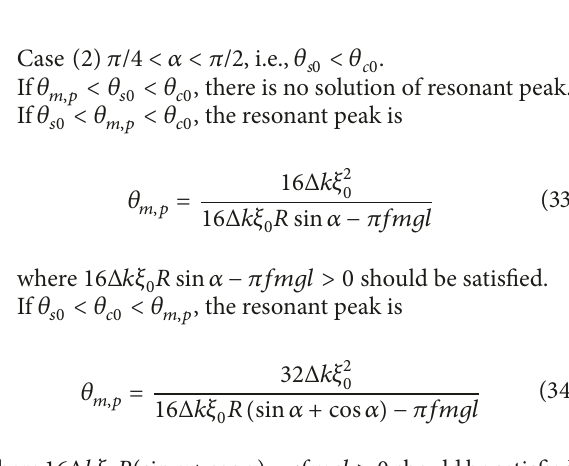
Figure 13: Influence of excitation direction on resonant